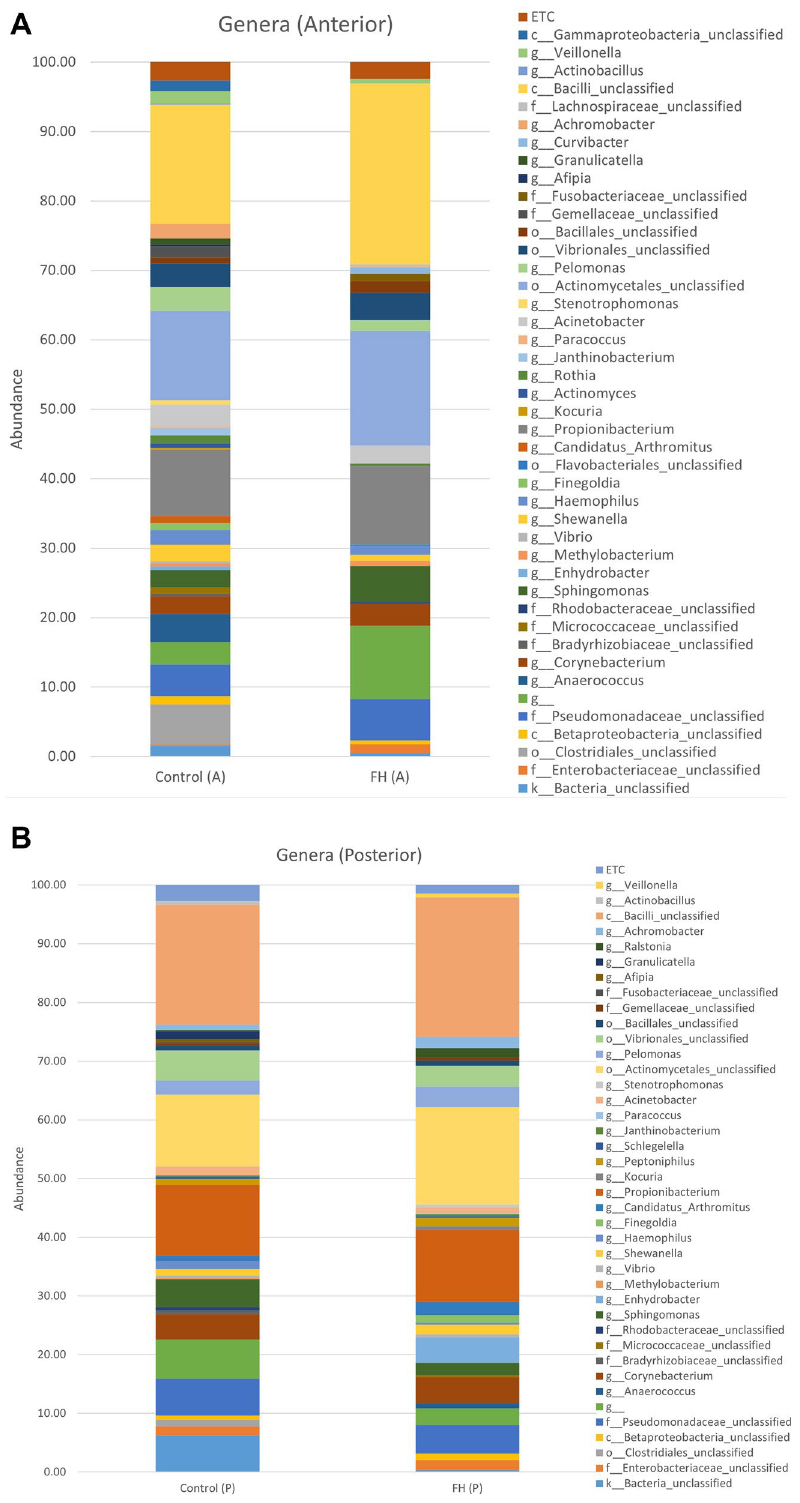
Figure 4. Average values of bacterial genera groups obtained in the intestinal microbiota samples in posterior (P) and anterior (A) sections ( A , B , respectively). Control (C-number) and N. gaditana hydrolyzed (FH-number) diets. ETC: genera represented <